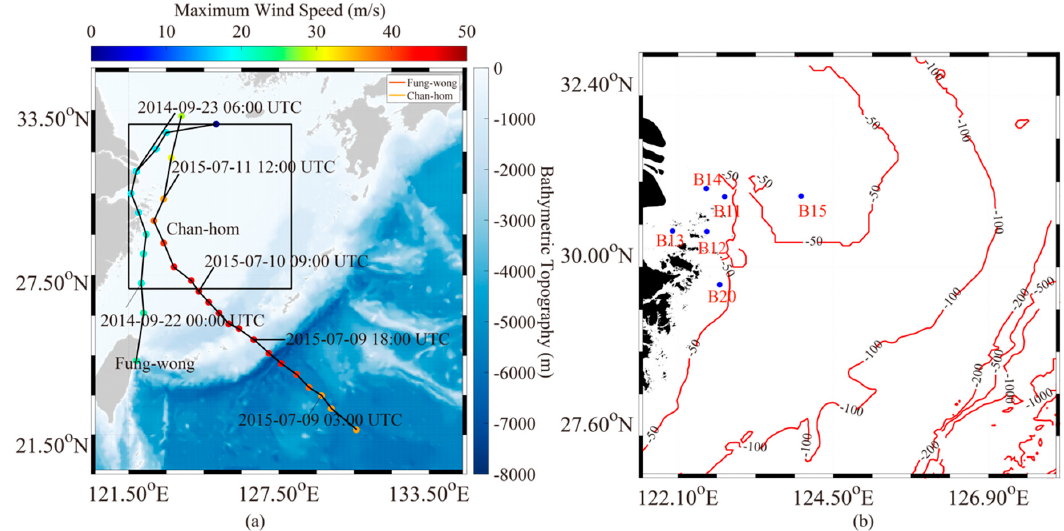
Figure 1. ( a ) Water-depth map of the selected region in the East China Sea, in which the red and blue lines represent the tracks of Typhoons Fung-wong (2014) and Chan-hom (2015), respectively, and the colored dots represent the maximum wind speeds of the typhoons. The area inside the black square is the geographic region around the Zhoushan Islands, China; ( b ) bathymetric topography of the study area corresponding to the black square in Figure 1a, in which the black dots are the available measurements from moored